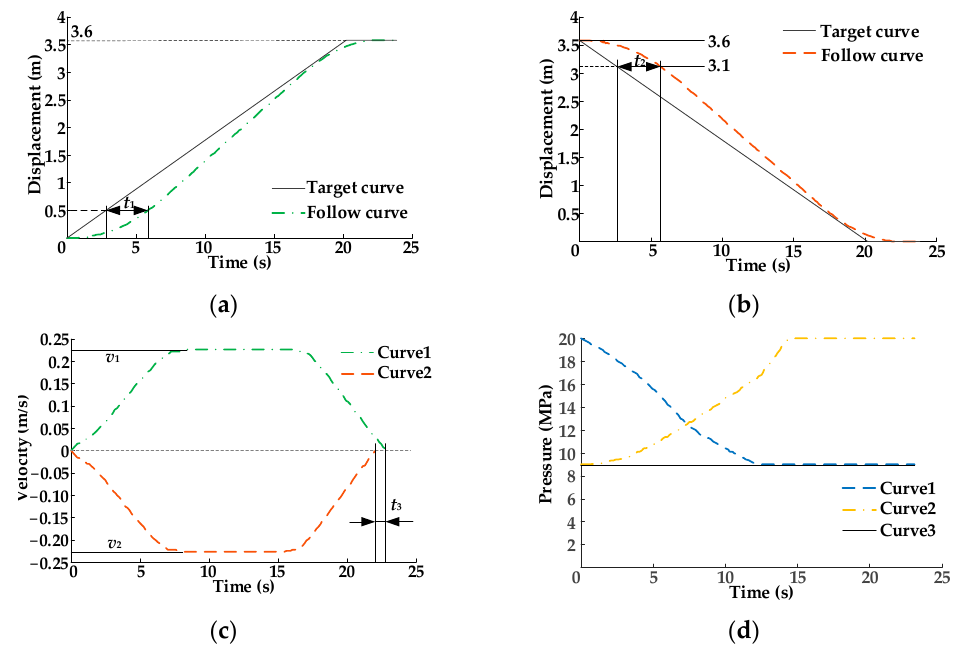
Figure 8. Regulation characteristic curves of the hydraulic traction system: ( a ) rising displacement curves of hydraulic cylinder piston rod; ( b ) descending displacement curves of the hydraulic cylinder piston rod; ( c ) velocity curves of the hydraulic cylinder piston rod; ( d ) oil source output/input pressure curves of the hydraulic traction system.